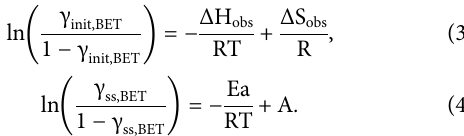
Frontiers in Environmental Science |